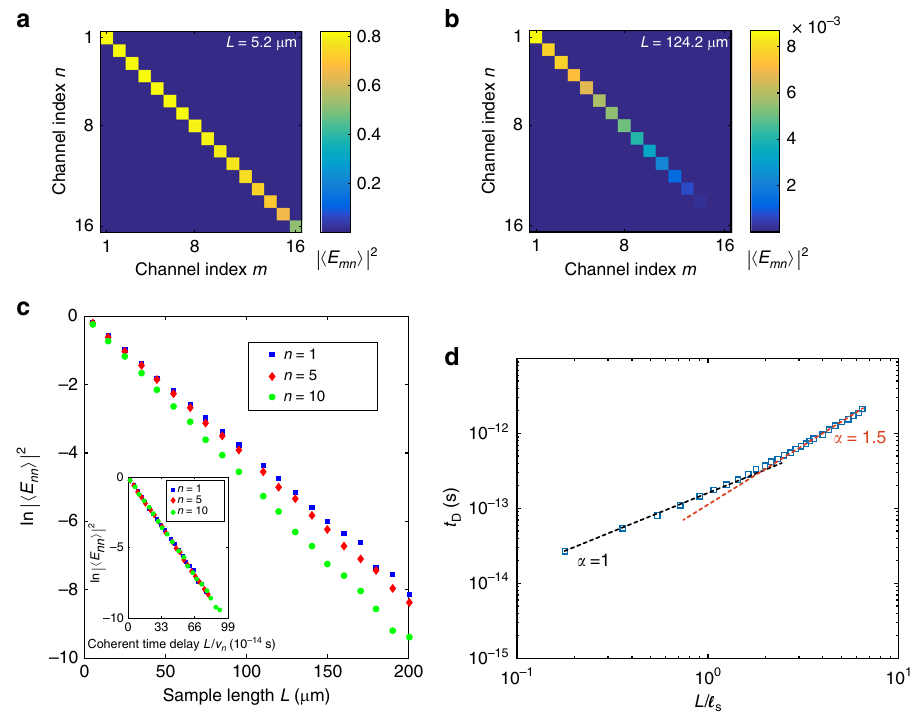
Fig. 1 Simulations of wave transmission in opaque and translucent samples. a , b Average transmitted intensity | 〈 E mn 〉 | 2 for different incident and output waveguide modes. The coherent intensity, for m = n , is substantial for L = 5.2 μ m and negligible for L = 124.2 μ m. c Scaling of the coherent intensity. The inset shows the scaling for three incident waveguide modes with n = 1, 5, 10. The variation of | 〈 E nn 〉 | 2 with coherent time delay L / v n for these modes with longitudinal velocities v n collapses to a single curve and falls exponentially to give a scattering length of ℓ s = 27.2 ± 0.2 μ m. The scattering length is given by, ℓ s = c τ s , where τ s is the mean free time obtained from the decay rate in the insert. d Log-log plot of the transmission delay time t D with sample length L . The dashed lines indicate different exponents α of the power law scaling. The transition from linear scaling occurs at L ~ ℓ . As L increases the value of α approaches